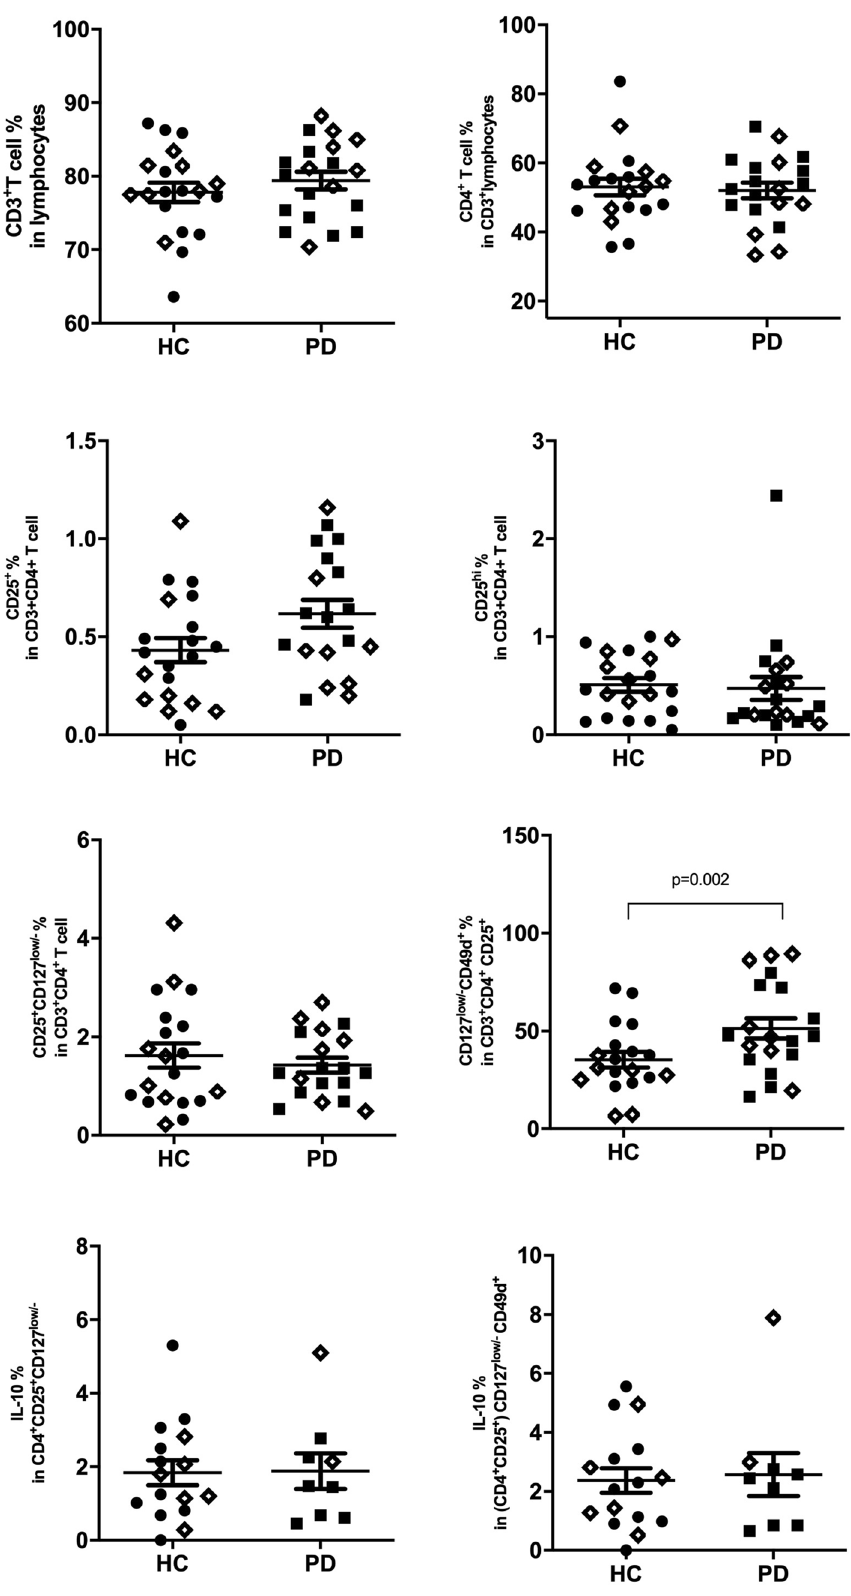
Figure 3. Frequencies of T cell subsets are shown on y axis for PD and control groups, symbol ◊ represents subjects enrolled in both RT-PCR and flow cytometry